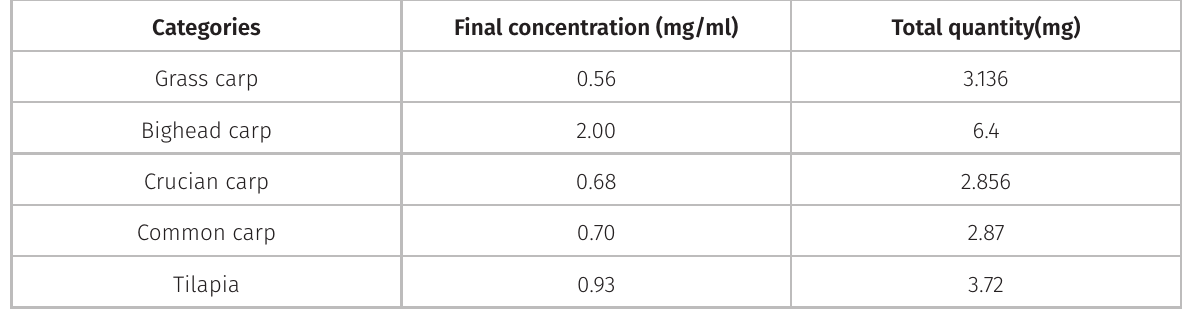
Table I. The final concentration and quantity of purified IgM from five categories.